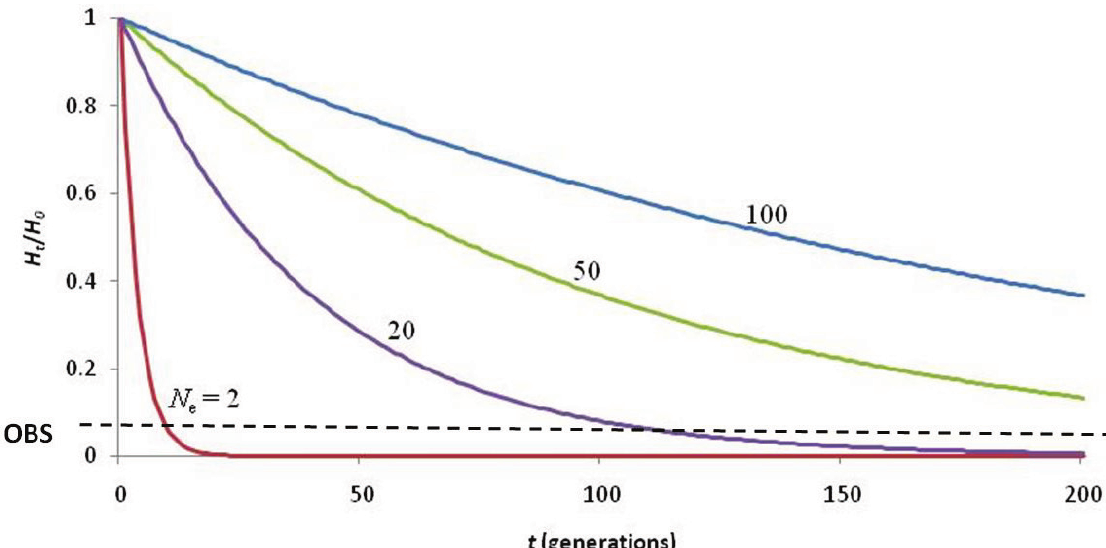
/ H ) over time ( t ) using Figure 3. Calculations describing the loss of heterozygosity ( H t 0 various values of effective population size ( N ) to explain the low of genetic diversity e / H = 0.067; black dashed line). The 19th century hunting induced bottleneck (observed H t 0 was not of adequate duration (< 10 generations) to deplete genetic diversity to such low levels, even if N = 2. Hunting of seals to N = 20–50 since the arrival of the first e e Hawaiians (~2,000 years ago) would have depleted heterozygosity to observed levels. The most likely scenario is that naturally low genetic diversity (due to being a large, insular carnivore) was reduced by extirpation of seals in the MHI upon arrival of the first Polynesians, and further depleted by extensive hunting of seals in the NWHI by Western sealers of the 19th century.